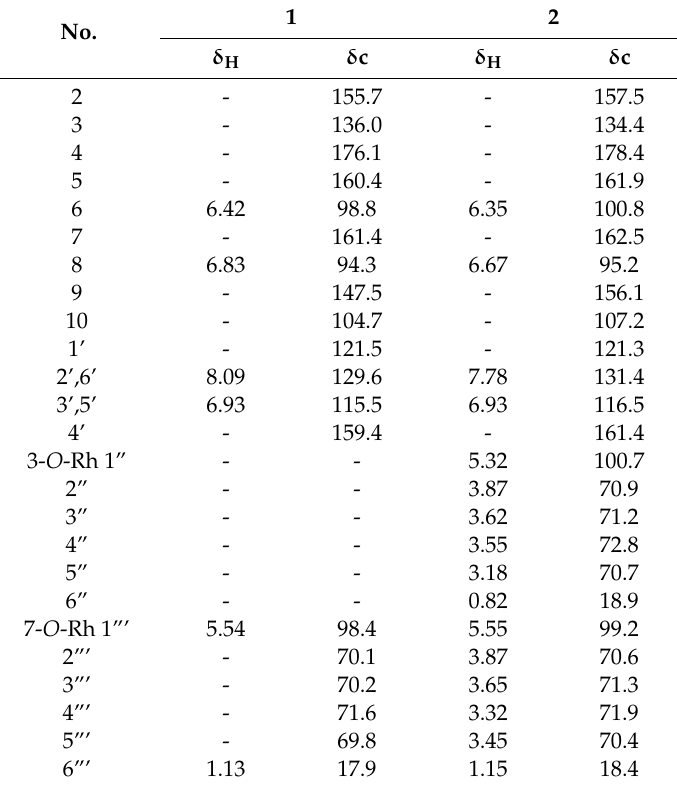
Table 1. 1 H- and 13 C-NMR assignment of compounds 1 and 2